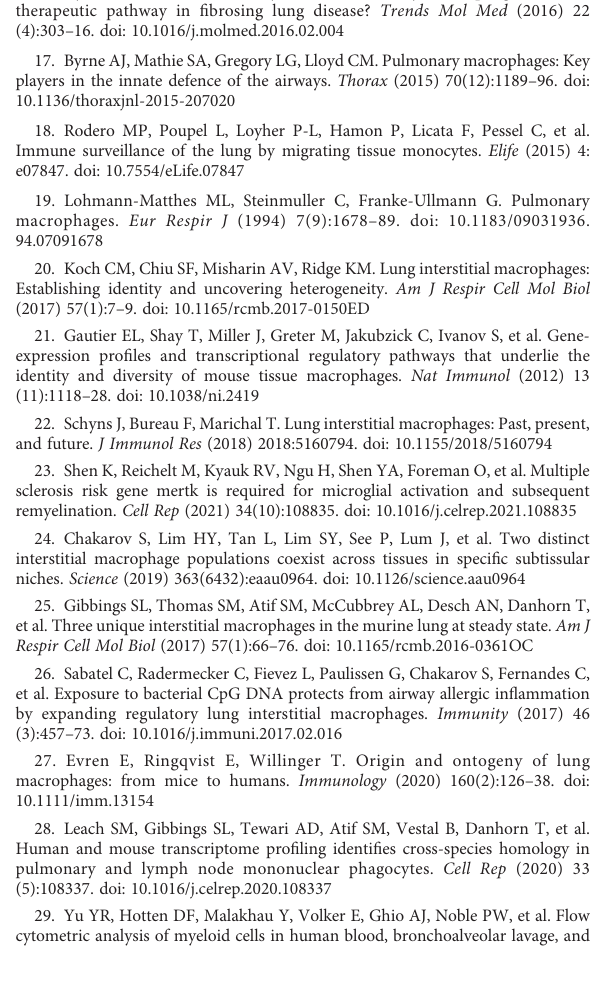
Figure 1 used cartoon elements from Servier Medical Art